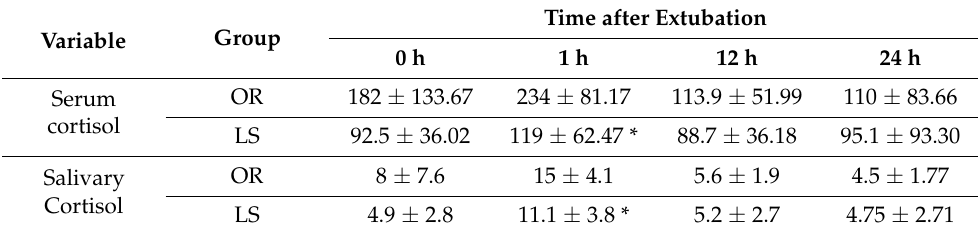
Table 4. Mean ± SD values of serum and salivary cortisol recorded after